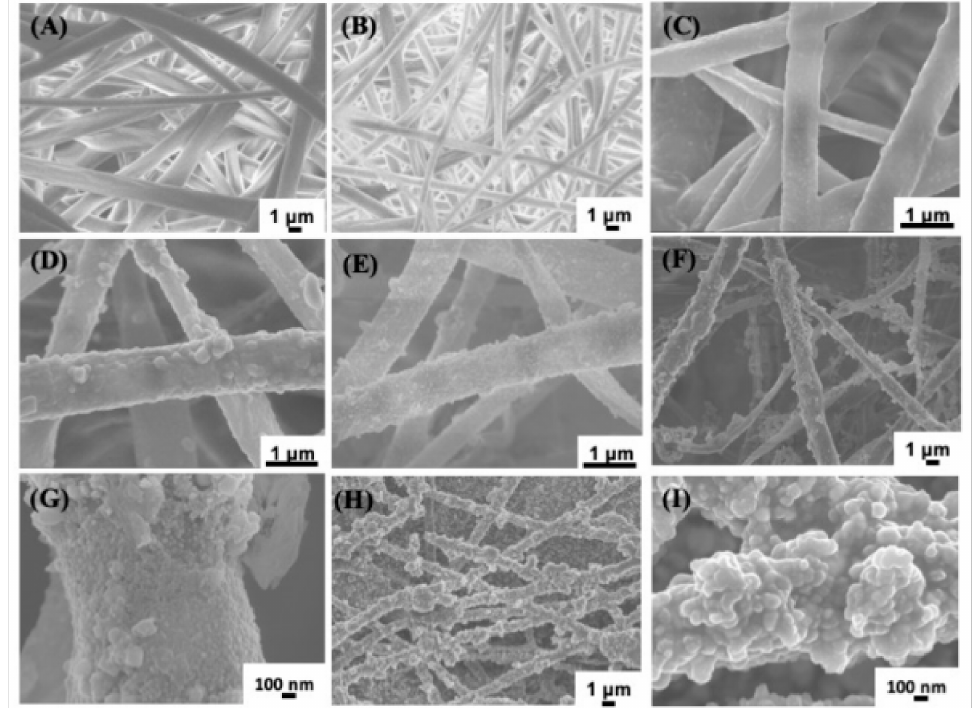
Figure 6. SEM images of different samples. Poly(L-lactide) (PLLA) ( A ), PLLA@PDA ( B ), PLLA@Ag1 ( C ), PLLA@Ag3 ( D ), PLLA@Ag6 ( E ), PLLA@Ag9 ( F , G ), and PLLA@Ag 24 ( H , I ). Reprinted with permission from Frontiers